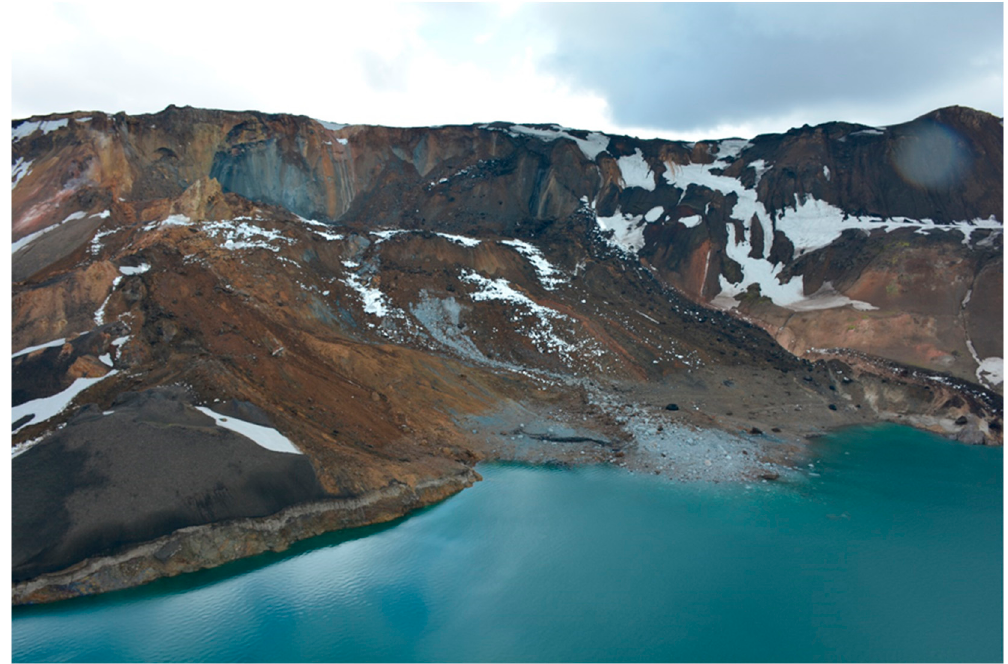
Figure 2. The rockslide in Askja on 7 July 2014 (location map is on Figure 6). The slide was initiated at 1400 m a.s.l. and fell into the Öskjuvatn Lake at 1056 m height. The width of the slide at the main scarp is about 8–900 m and the runout length to the lake is around 1100 m (Photo by Þorsteinn Sæmundsson, 2014).